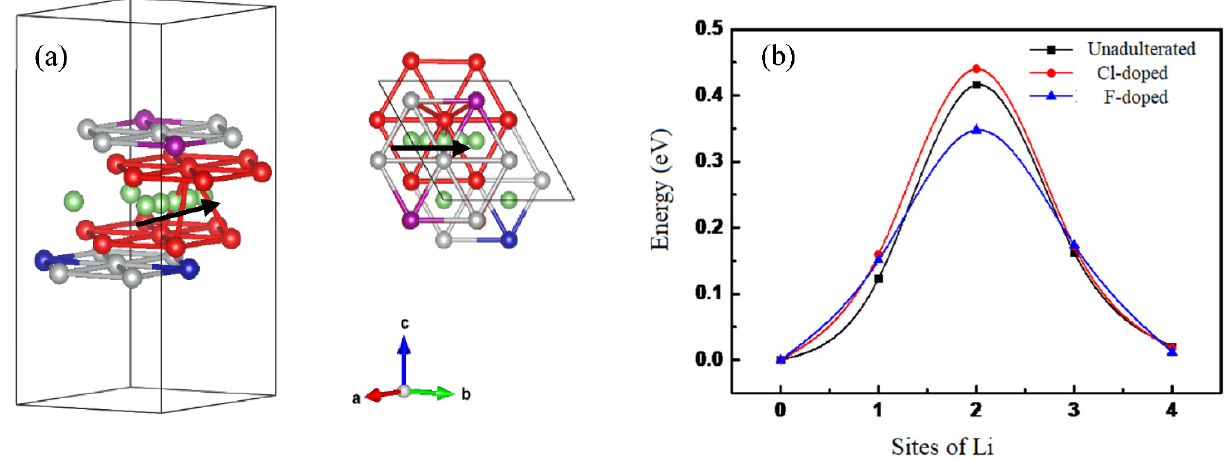
Figure 12. The lithium diffusion profiles of Unadulterated, Cl-doped and F-doped atoms in the lithium layer far away from the doping site. ( a ) the TSH diffusion pathway of Li, ( b ) The NEB energy profiles. Color code for spheres: green—Li atoms, grey—Ni atoms, violet—Mn atoms, red—O atoms, blue—Co atoms. The arrow indicates the diffusion path of Li 1 to Li 5 .